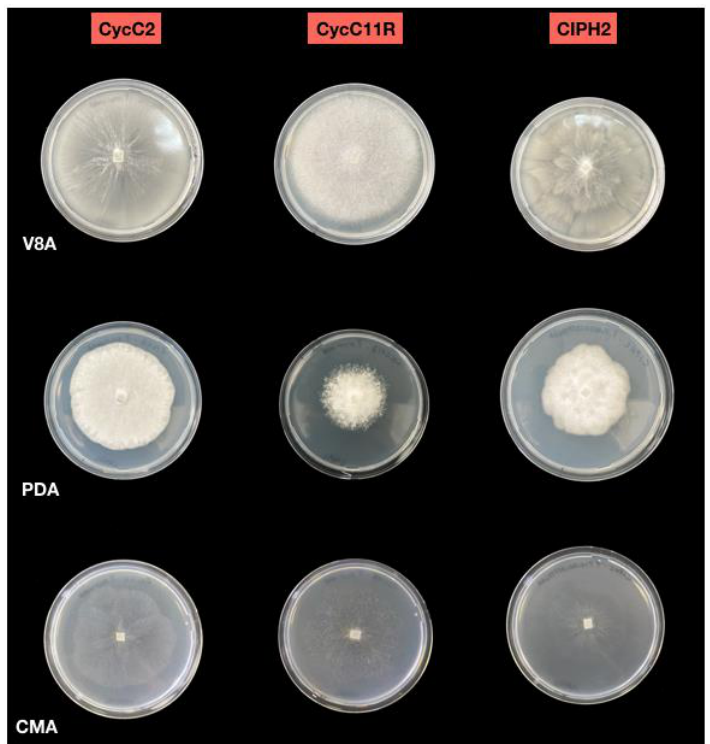
Figure 2. Colony morphologies of Phytophthora multivora (CycC2), P. nicotianae (CycC11R) and P. pseudocryptogea (CIPH2) after 7 days of growth at 20 °C in the dark on V8A, PDA and CMA.